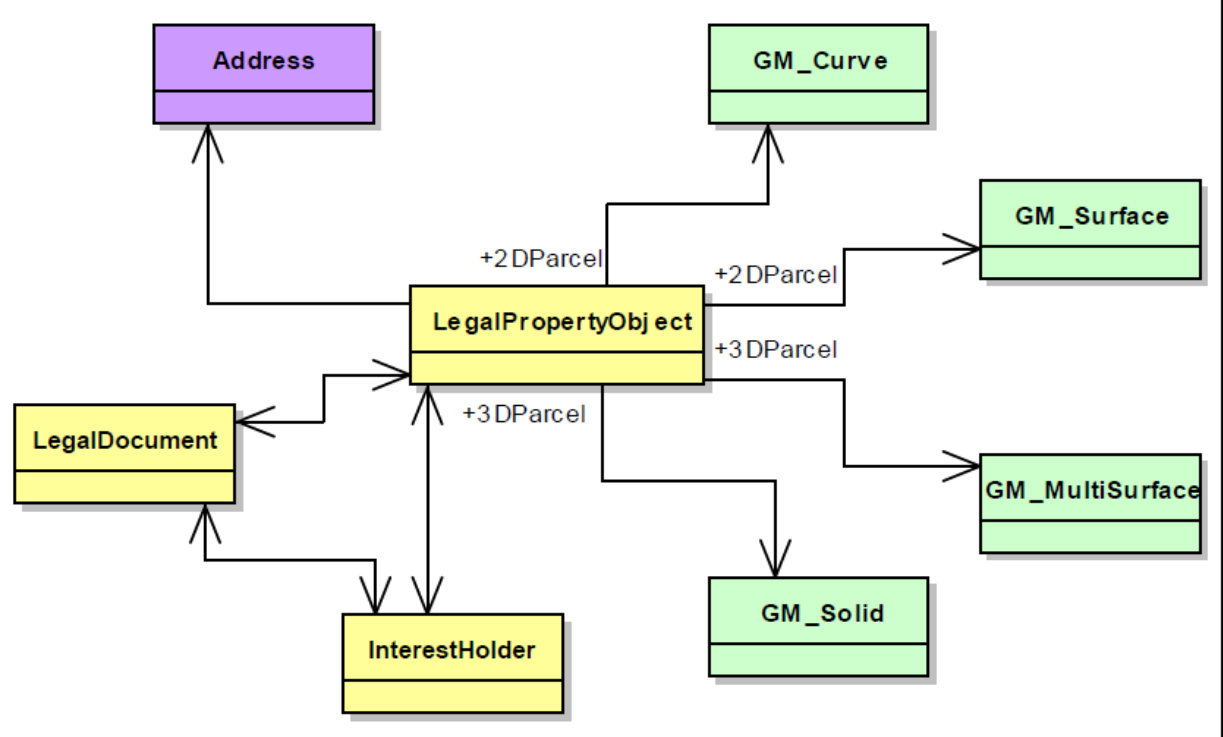
Figure 5. Geometric representation of the